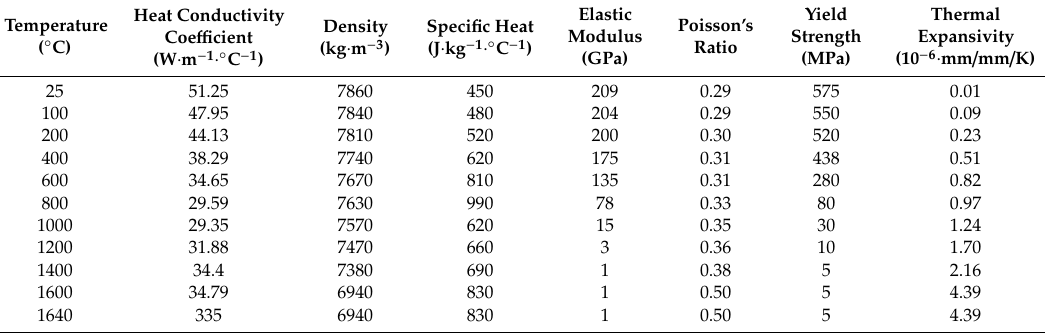
Table 4. Mechanical properties of CF62 reproduced from [19], with permission from Taiyuan University of Science and Technology,